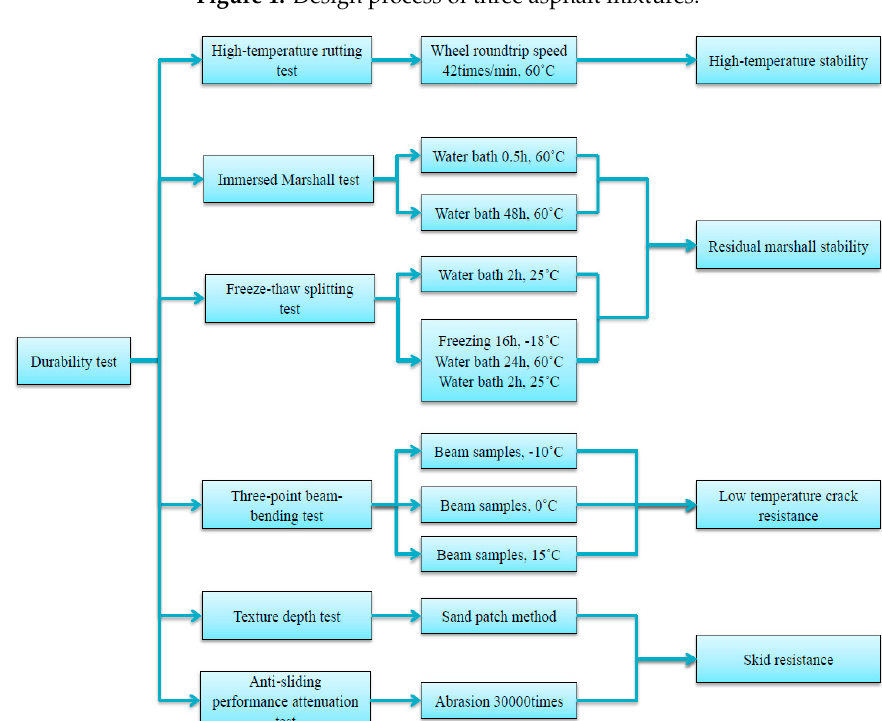
Figure 2. Flow chart of the durability test of three asphalt mixtures.